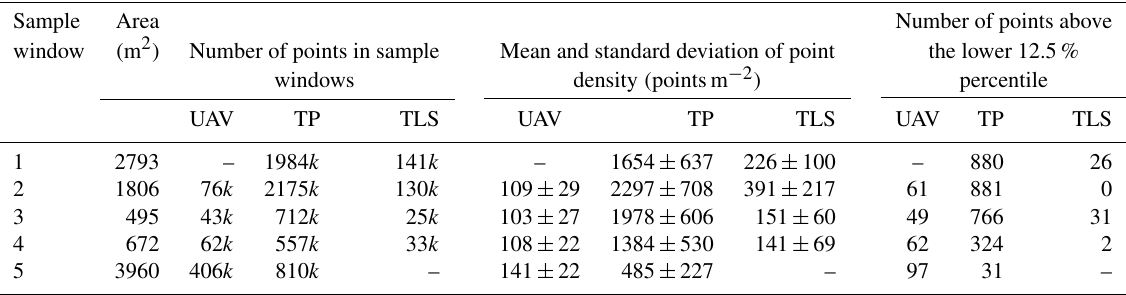
Table 2. Area and number of points in each sample window on the Forni Glacier terminus, mean and standard deviation of local point density and number of points above the lower 12.5% percentile in each window. k stands for thousands of points. UAV refers to UAV photogrammetry, TP to terrestrial photogrammetry and TLS to terrestrial laser scanning.